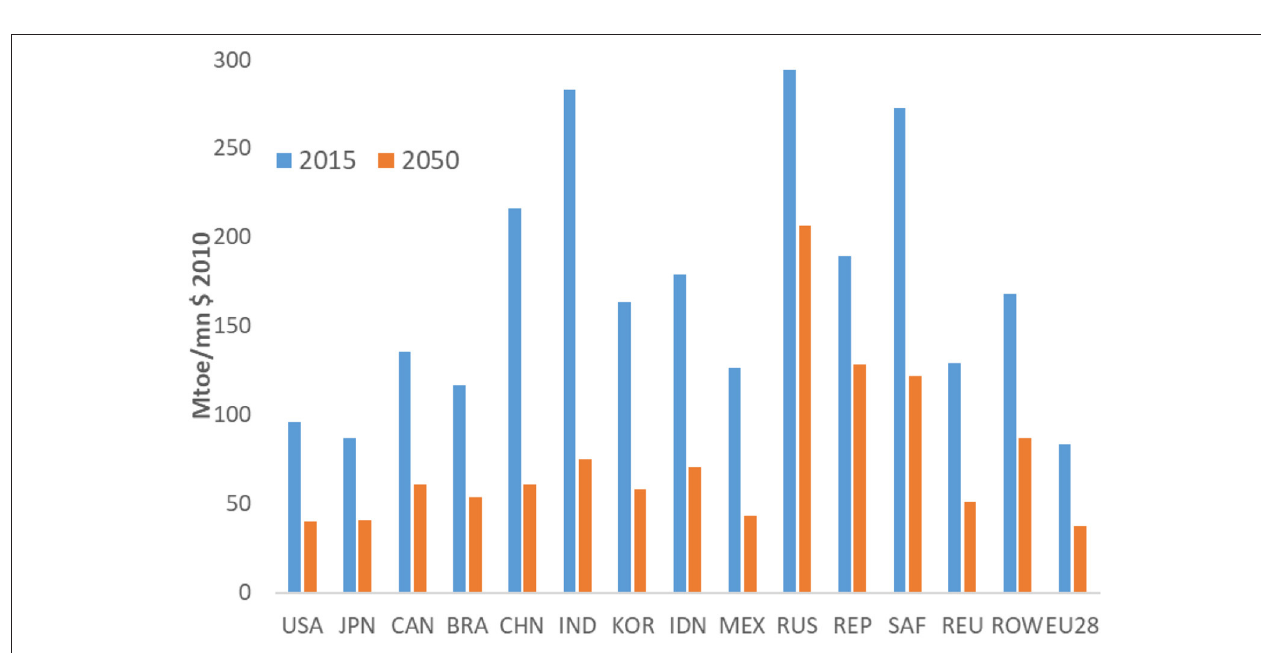
FIGURE 10 | Development of energy intensity of GDP in major economies in the 2DEG scenario.